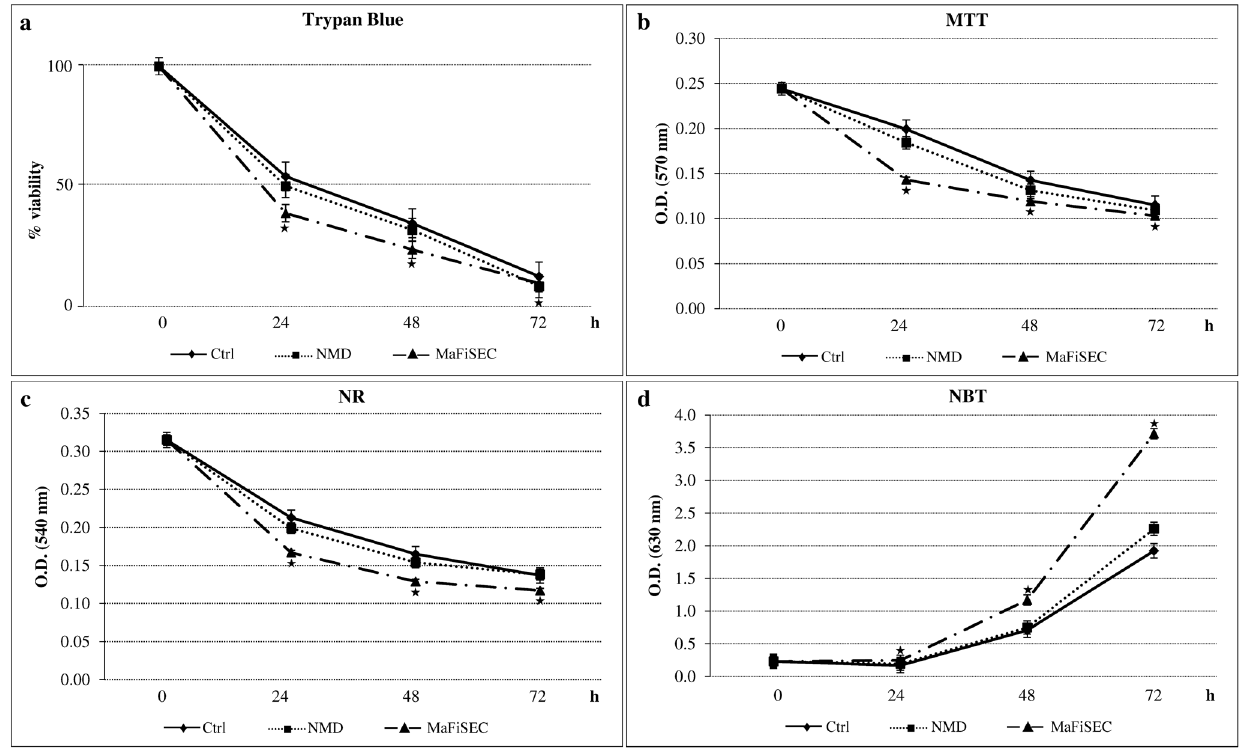
Figure 3. Time-course of SMF cytotoxicity. Viability of SMF-exposed lymphocytes: (a) Trypan Blue dye exclusion assay; (b) MTT assay; data are reported as percentage of viability of unexposed lymphocytes at T0, taken as 100%. (c) Lysosomal activity of SMF-exposed lymphocytes, NR assay. (d) ROS production by SMF-exposed lymphocytes, NBT assay. Error bar represents the SE of six independent experiments, each done in duplicate. Star indicates significant value with respect to unexposed and NMD-exposed cells (p , 0.0167). Control value is the average of the values of unexposed cells cultured by using either flasks or Petri dishes. Ctrl=unexposed lymphocytes; O.D.=optical density; h=hours.